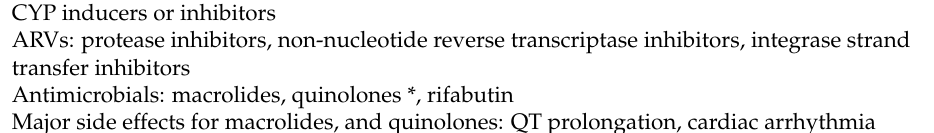
Table 2. Major drug–drug interaction actors in H. pylori treatment among co-infected people living with HIV. CYP inducers or inhibitors ARVs: protease inhibitors, non-nucleotide reverse transcriptase inhibitors, integrase strand transfer inhibitors Antimicrobials: macrolides, quinolones *,